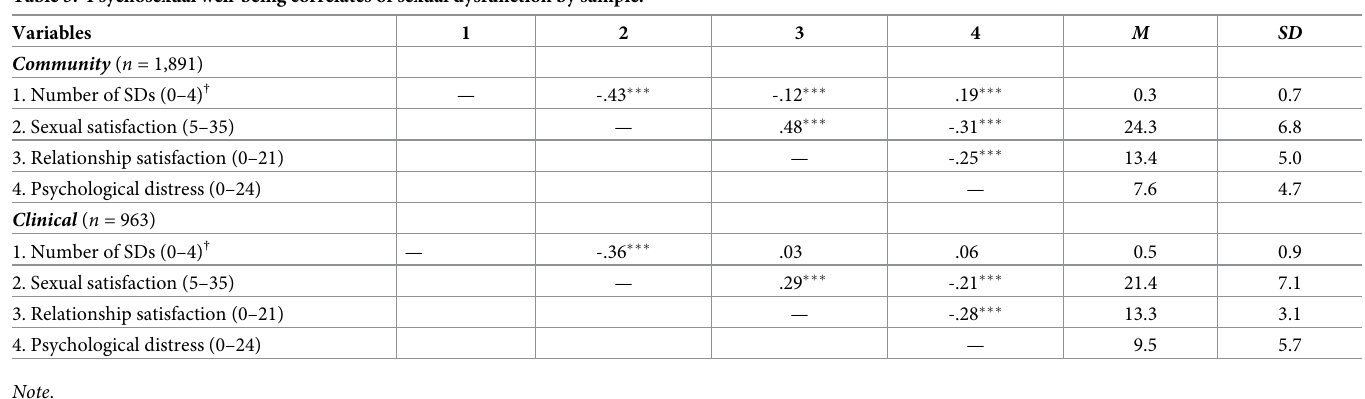
Table 3. Psychosexual well-being correlates of sexual dysfunction by sample.